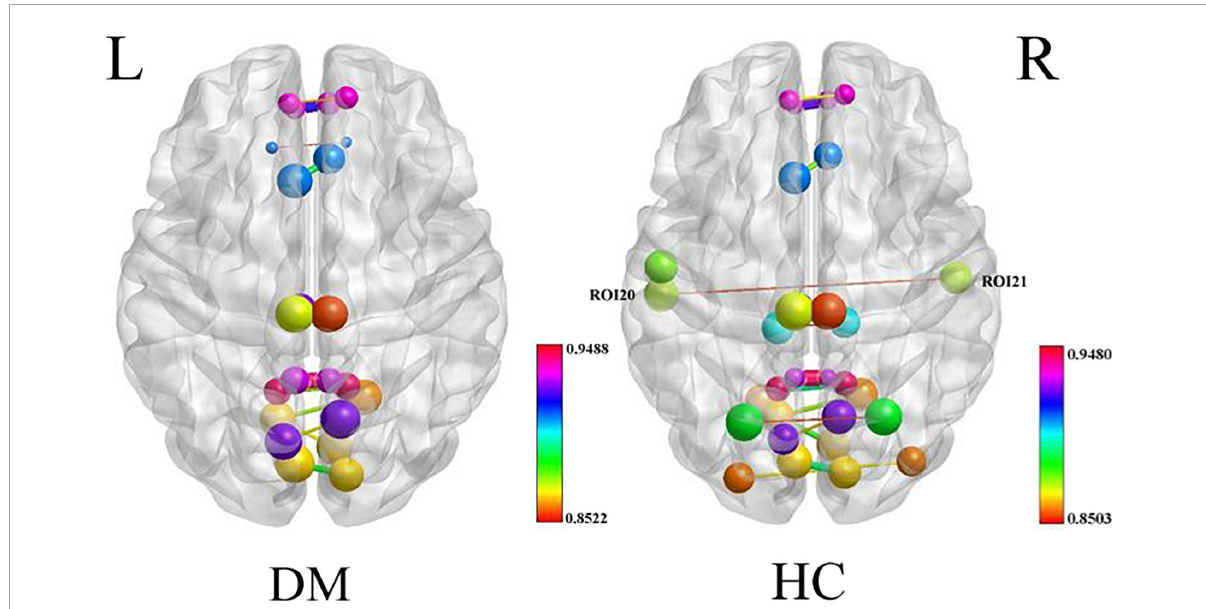
FIGURE4 Average connectivity in the T2DM and HC groups, long-range connectivity between the bilateral auditory cortexes is missing in patients with T2DM.